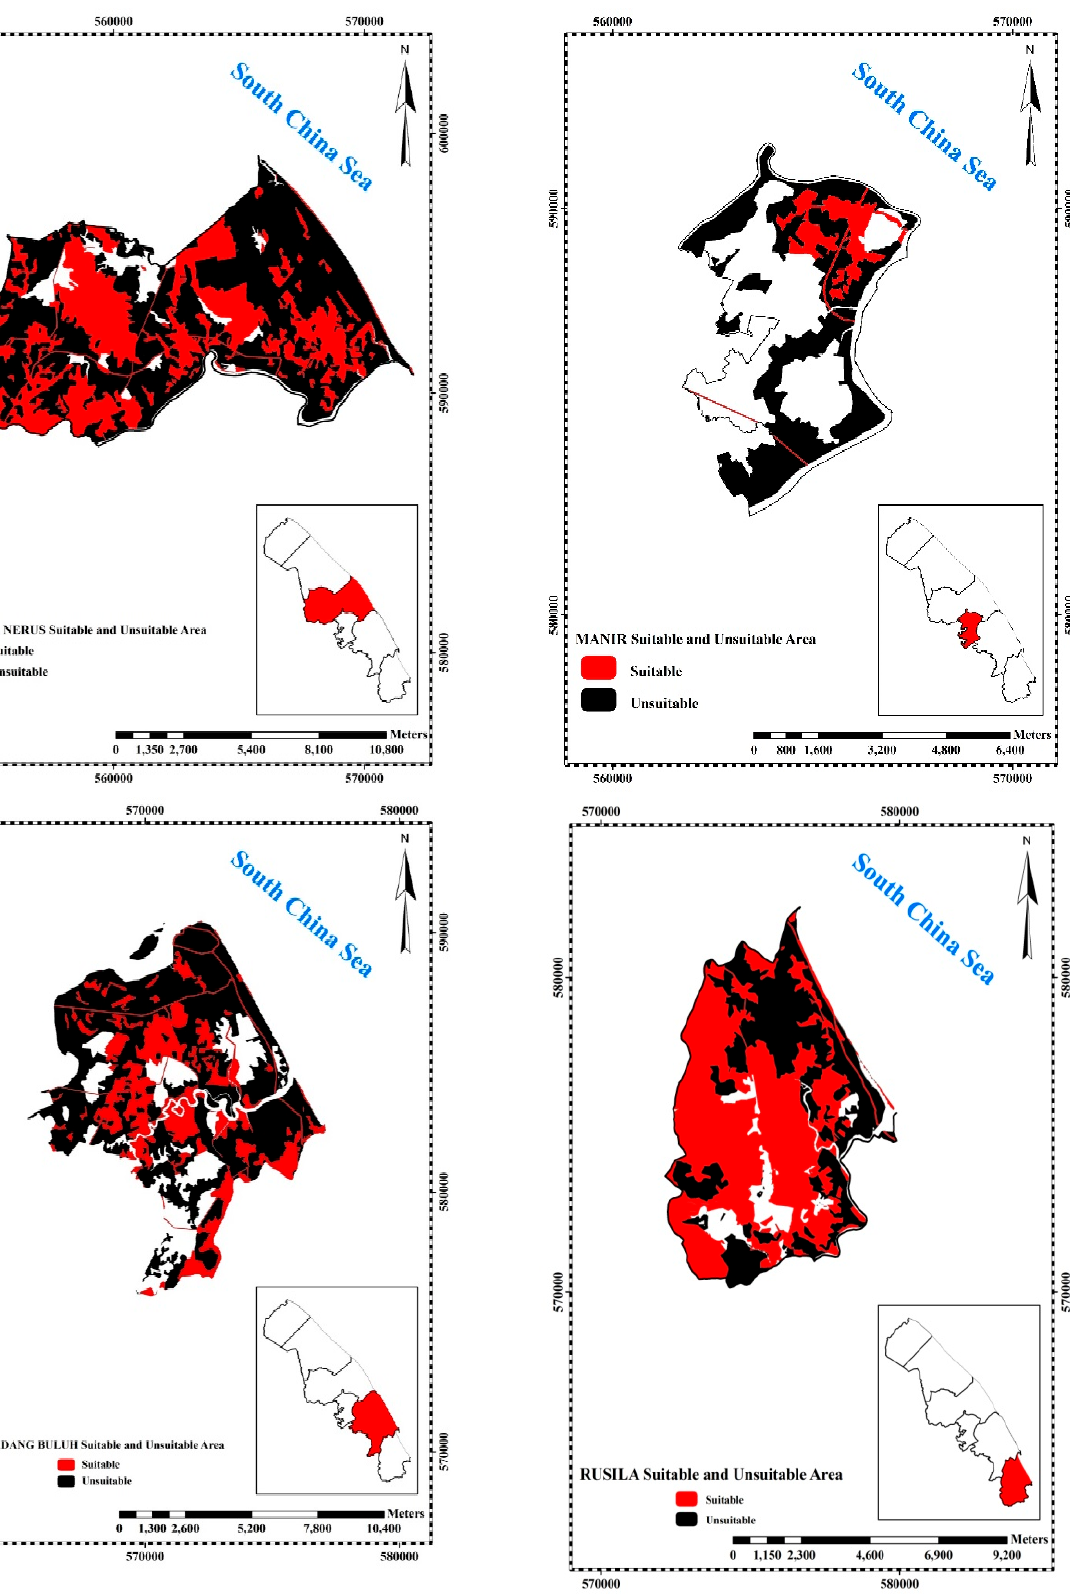
Figure 6. Suitability and unsuitability land-use maps for coastal city erosion.